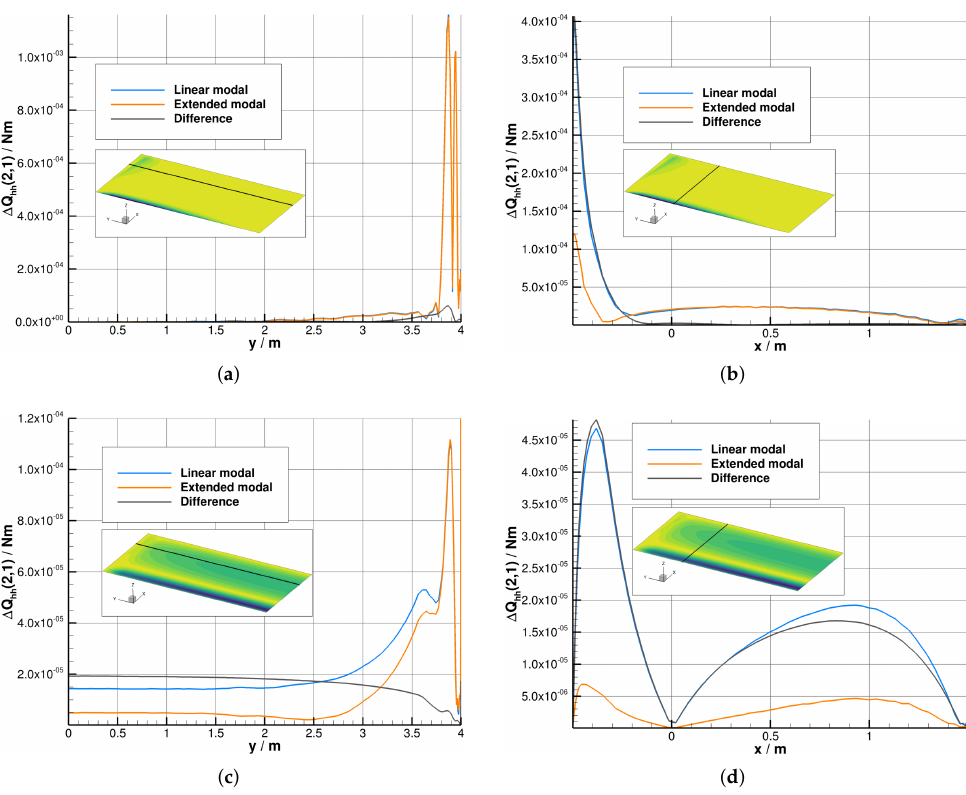
Figure 17. Nonlinear components of Q hh ( 2,1 ) along spanwise and chordwise slices (viscous flow, Mach 0.4). ( a ) Longitudinal component, spanwise distribution at x / c = 0.725; ( b ) longitudinal component, chordwise distribution at y / s = 0.7; ( c ) lateral component, spanwise distribution at x / c = 0.725; ( d ) lateral component, chordwise distribution at y / s =